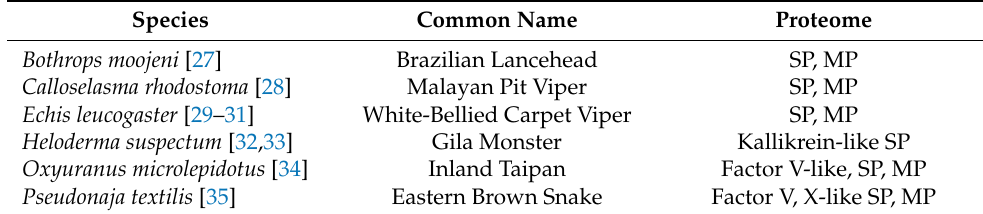
Table 1. Properties of procoagulant snake venoms